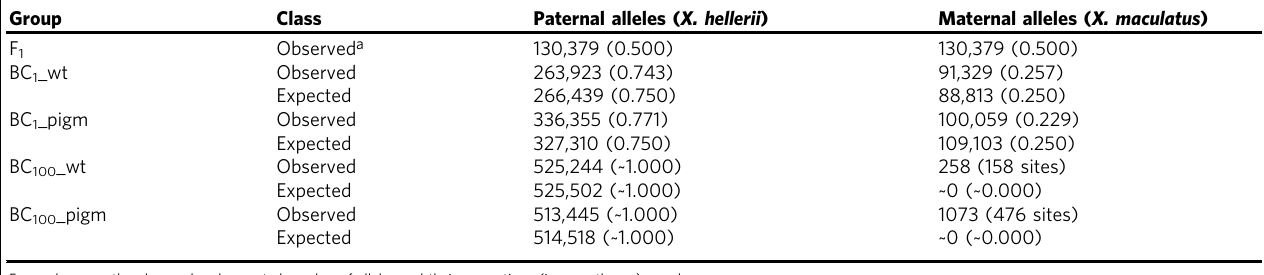
Table 1 Segregation patterns of the parental alleles